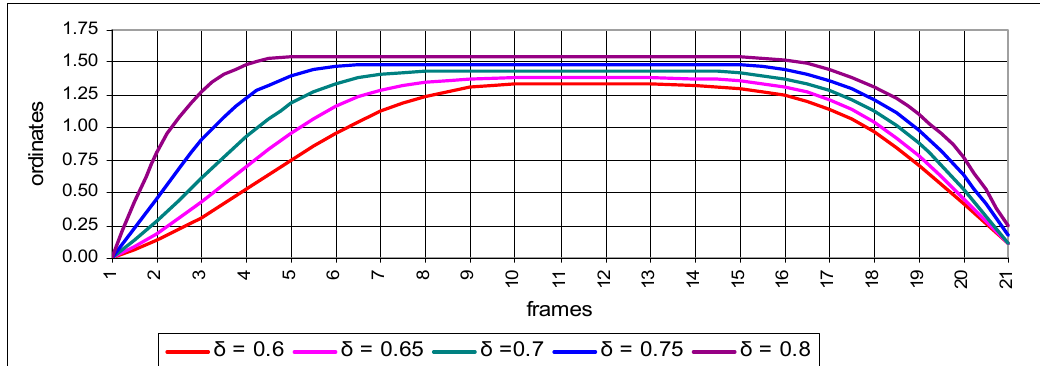
Figure 14. Main waterlines of Todd’s models of series 60.